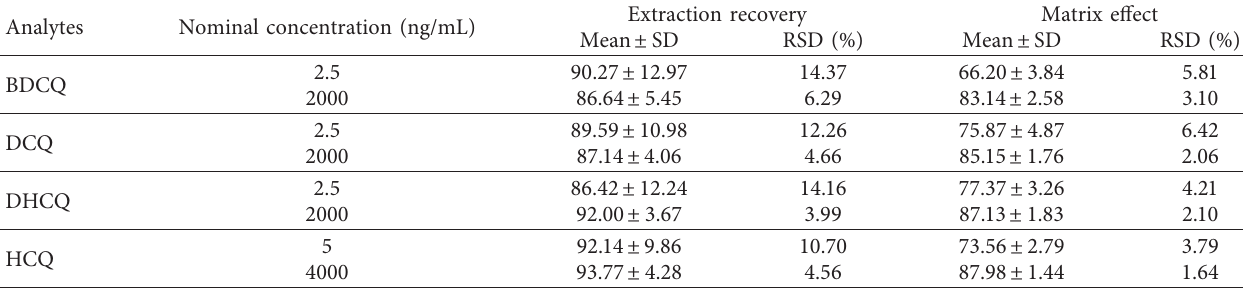
Table 2: Extraction recovery and matrix effect data of the analytes in rat blood ( n � 6). Analytes Nominal concentration (ng/mL)